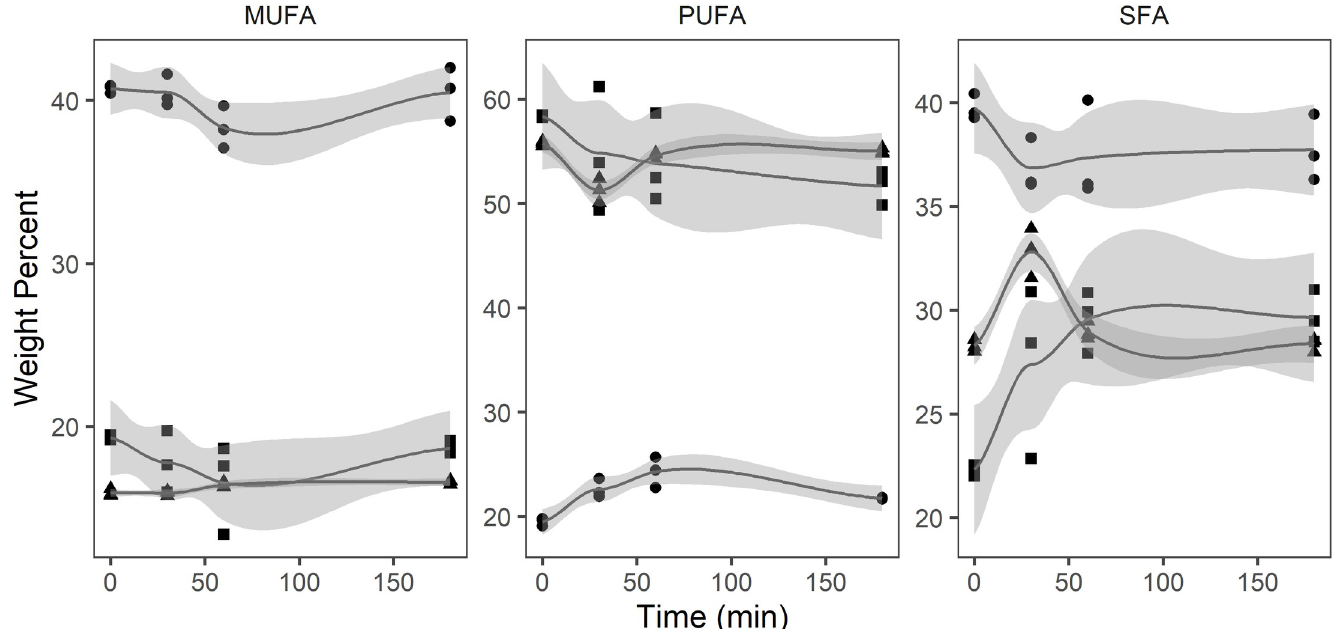
Fig 5. Monounsaturated fatty acids (MUFA), polyunsaturated fatty acids (PUFA), and saturated fatty acids (SFA) (weight percent) in free fatty acid (square), neutral lipid (circle) and polar lipid (triangle) fraction of krill oil (n = 3) during in vitro digestion.